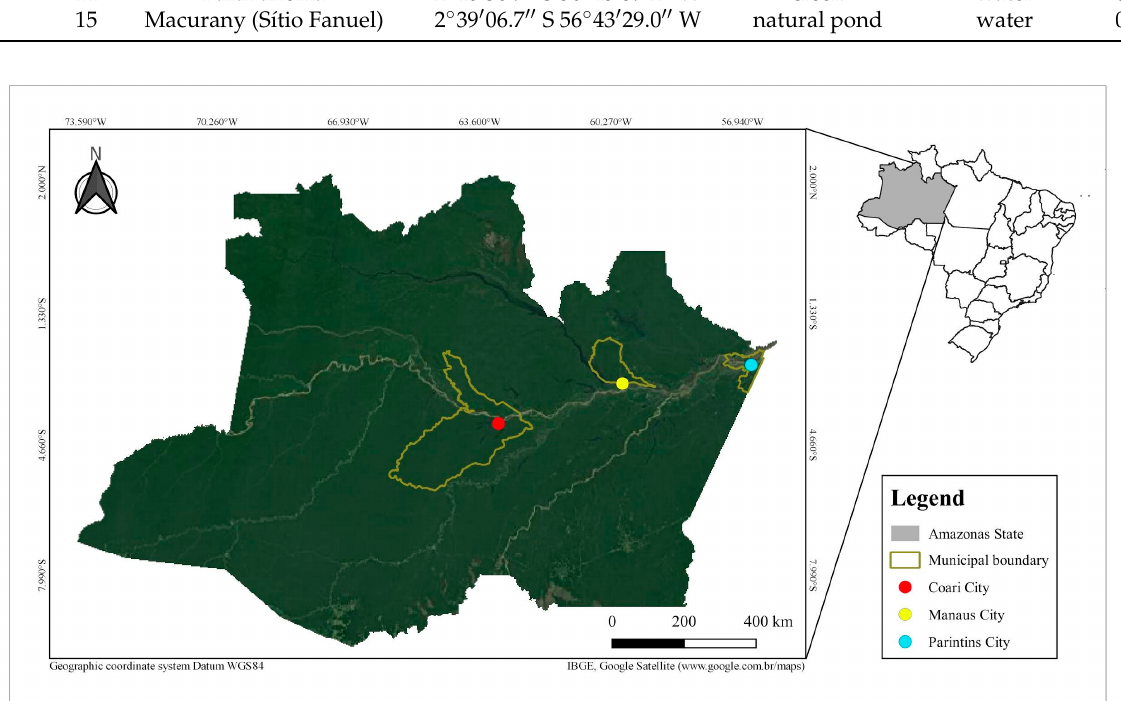
Figure 1. Sample collection locations. GPS coordinates, dates of collections and descriptions of collection sites are available in Table 1.